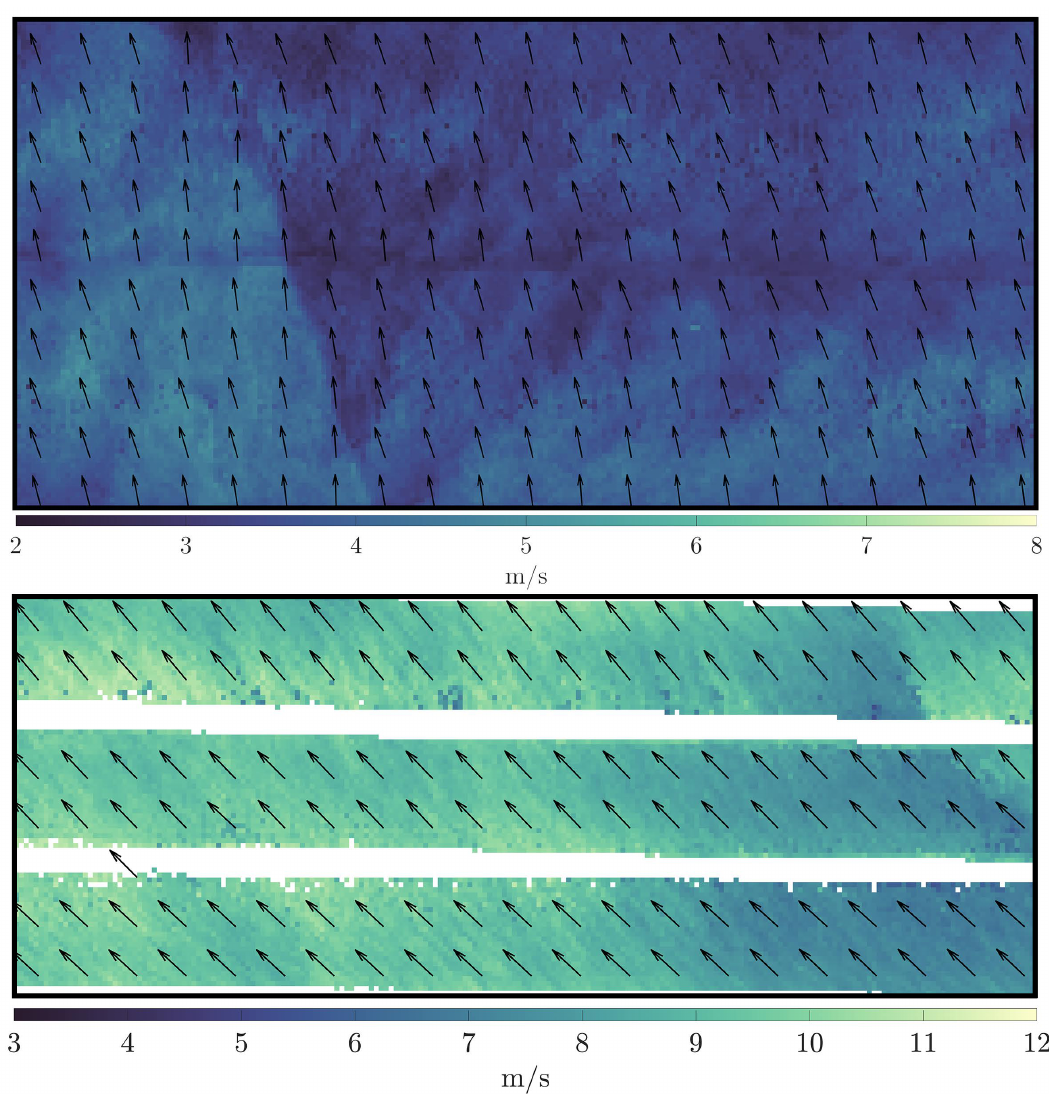
Figure 9. Mosaic of two retrieved vector wind fields from two flight lines each on March 25th ( top ) and 26th ( bottom ). Both fields are at 400 m resolution with vectors decimated by a factor of